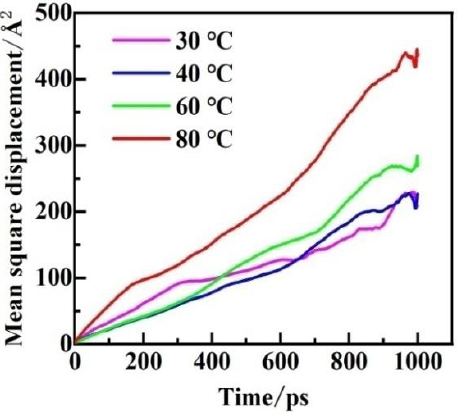
Figure 7. MSD curves of CH 4 in PVDF containing crude oil at 2.5 MPa.